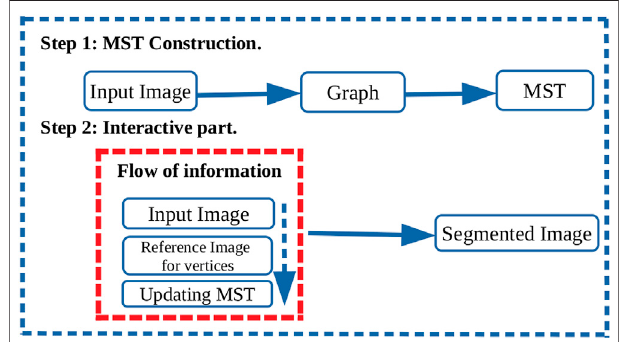
FIGURE1| Theschematic fl owdiagramshowsthesteps involvedinthe segmentationprocess.Step1:Theimageis fi lteredusingaGaussian fi lterand then weights are computed for the pixel neighbor graph. Then, the minimum spanningtree(MST)isconstructedfromthegraph.Step2:Theregionof interest (ROI) is segmented interactively. The ROI and the background are selected by clicking. Then, the MST is updated to separate the ROI from the background. New labels are assigned and reshaped back to the shape of the input image. The reshaped labels are visualized to show the segmented ROI from the